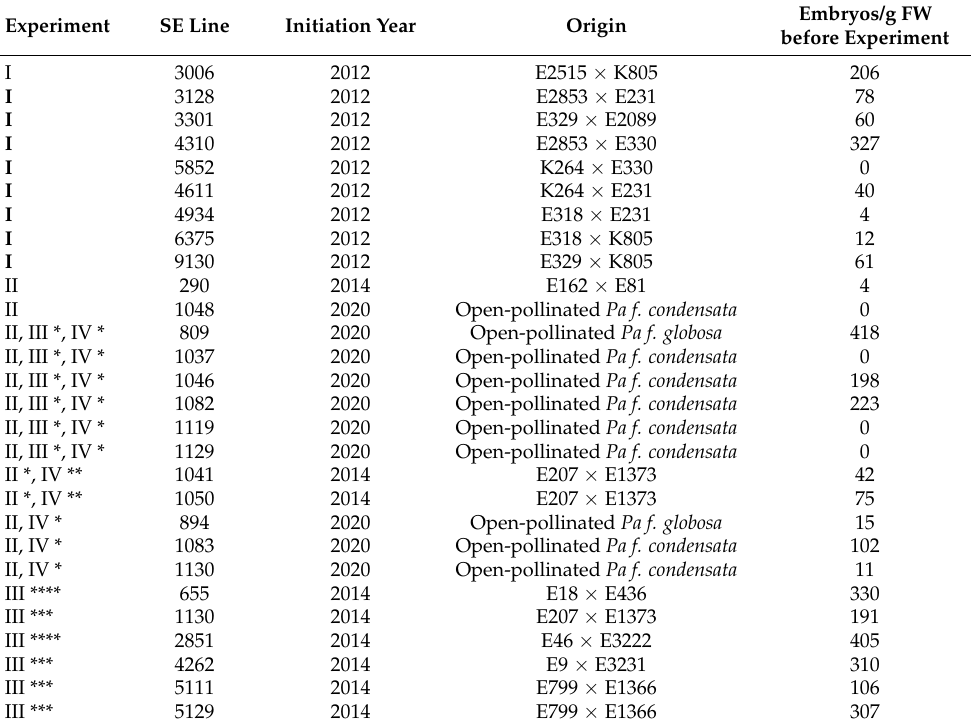
Table 6. Norway spruce SE lines used in the experiment using ABA in the pre-treatment media (I) storing embryogenic tissue at − 80 ◦ C (II), one post-thawing medium compared to two (III), and one pre-treatment compared to two (IV). The initiation years and origin (full-sib family or mother tree), embryo production capacity (embryos/g Fresh Weight), as well as the cryopreservation and thawing status of the line in each experiment, are